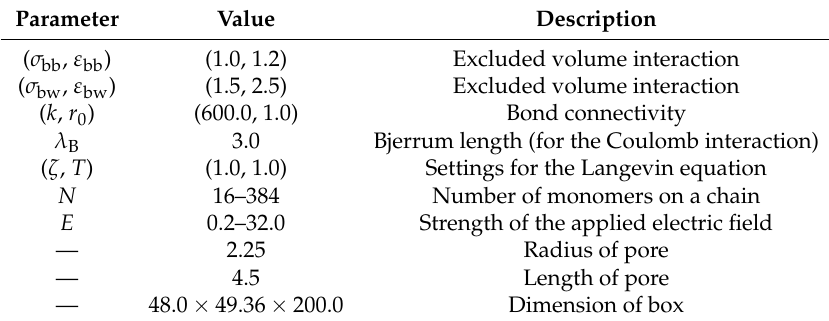
Table 1. Parameters of simulation, in the ( σ , m , τ u , e )